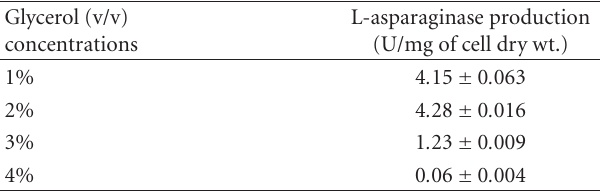
Table 1: L-asparaginase production by Nocardia levis grown in modified ISP-5 broth amended with di ff erent carbon sources.